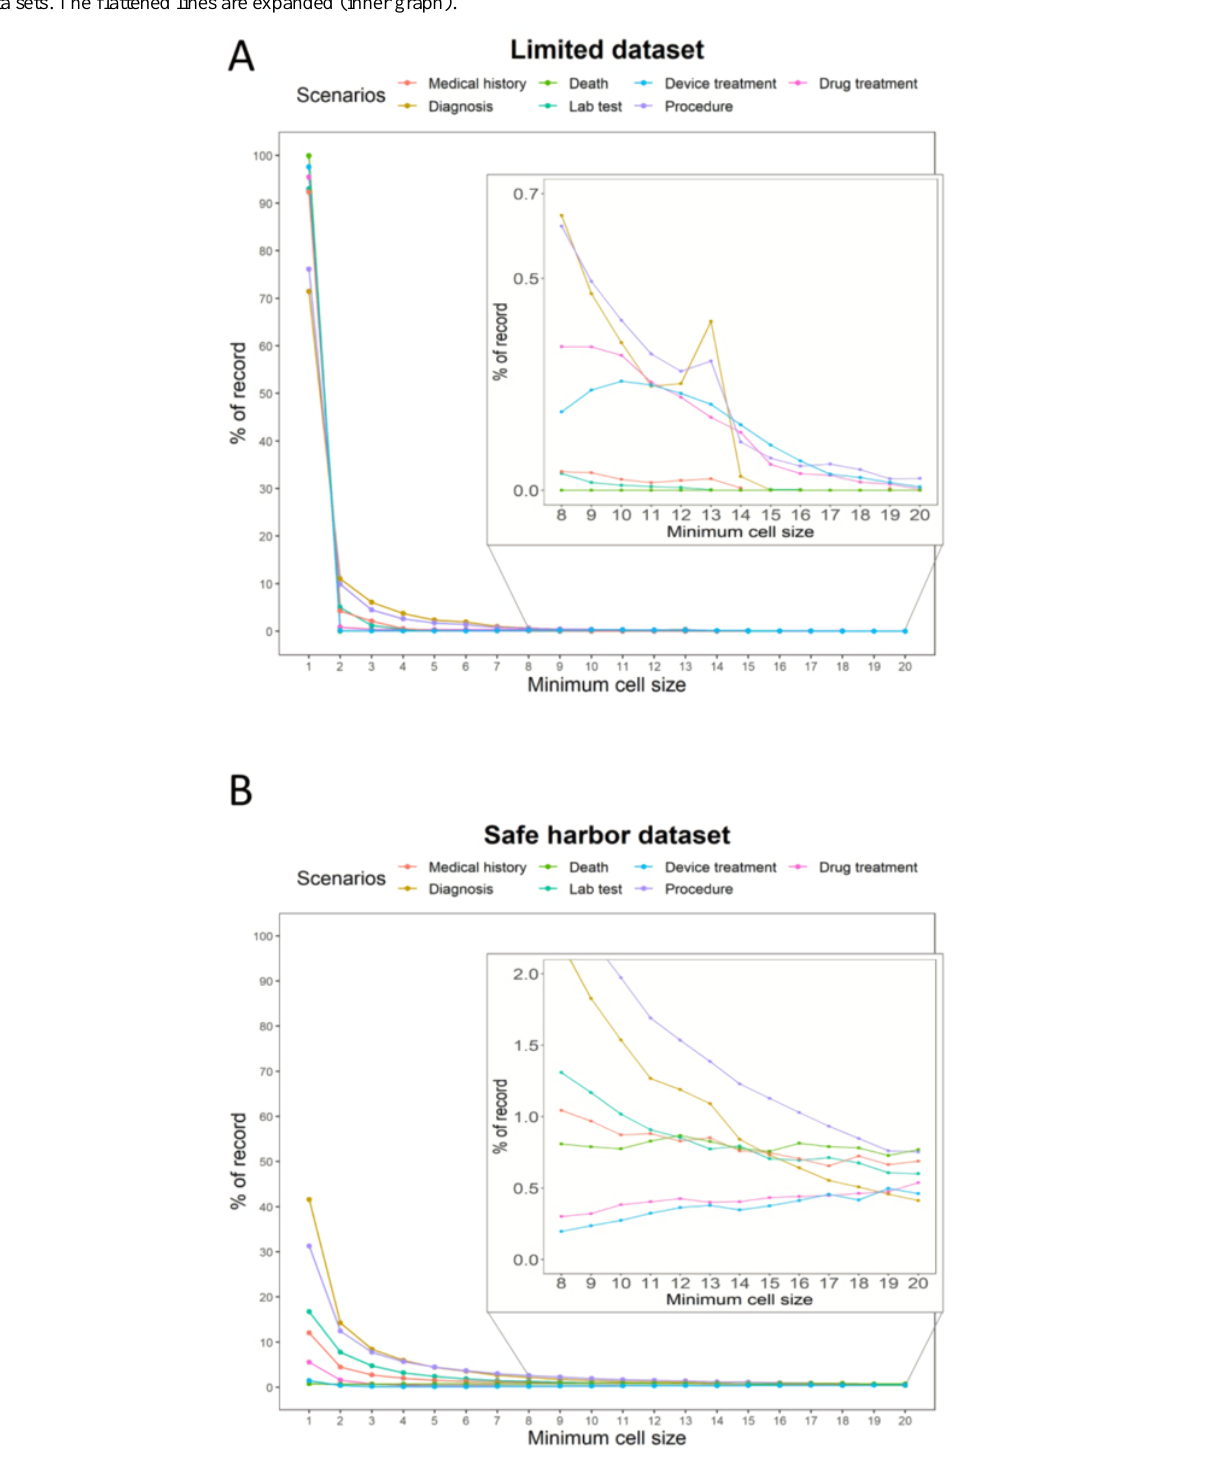
Figure 2. Percentage of records measuring the quasi-identifier privacy risk with a minimum cell size of 1–20 for the (A) limited and (B) safe harbor data sets. The flattened lines are expanded (inner